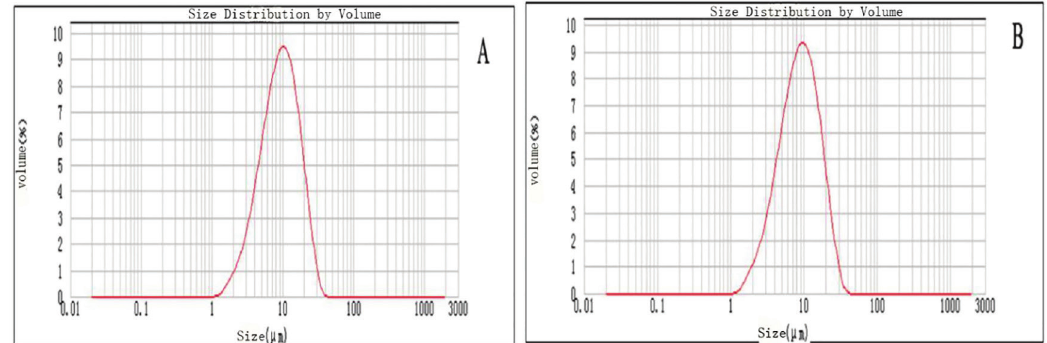
FIGURE 4 - Size distribution of TDF loaded PLGA microspheres: (A) Microspheres after freeze-drying; (B) Microspheres before